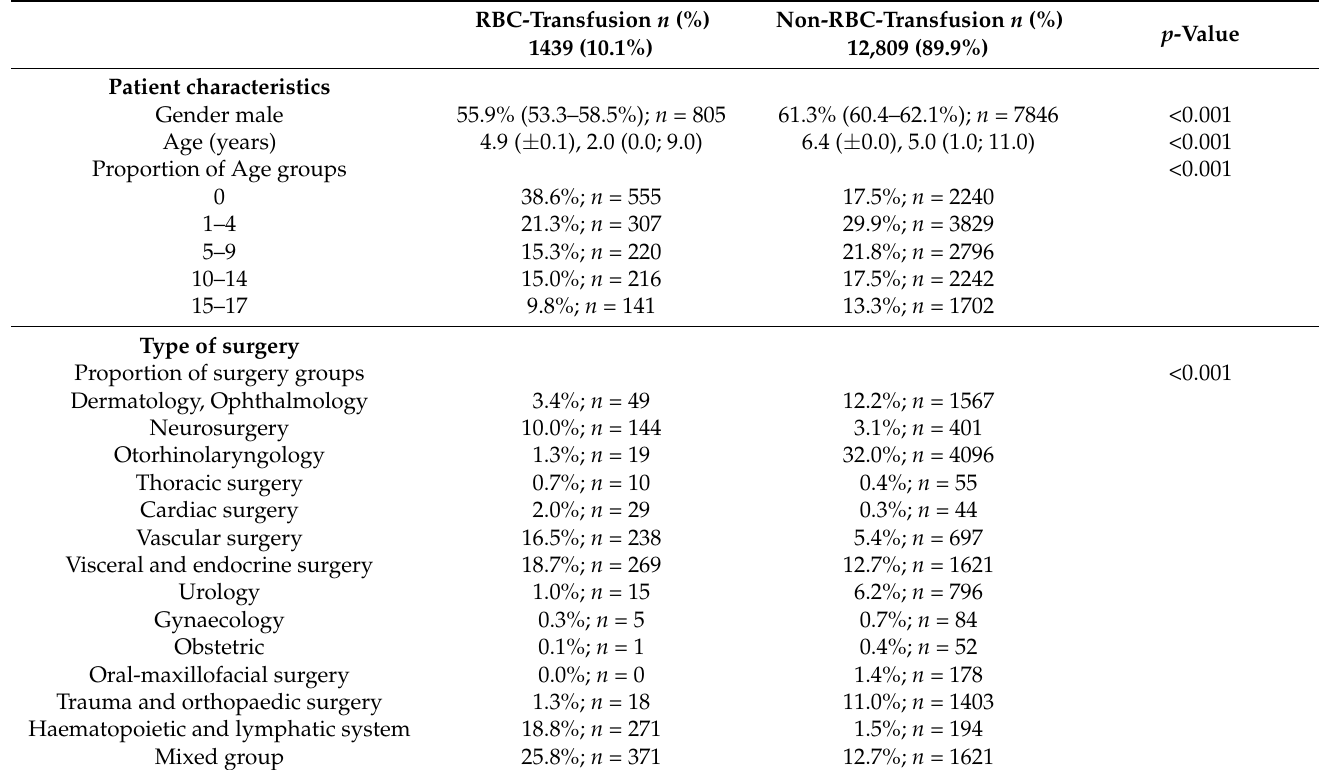
Table 1. Patient characteristics and type of surgery.